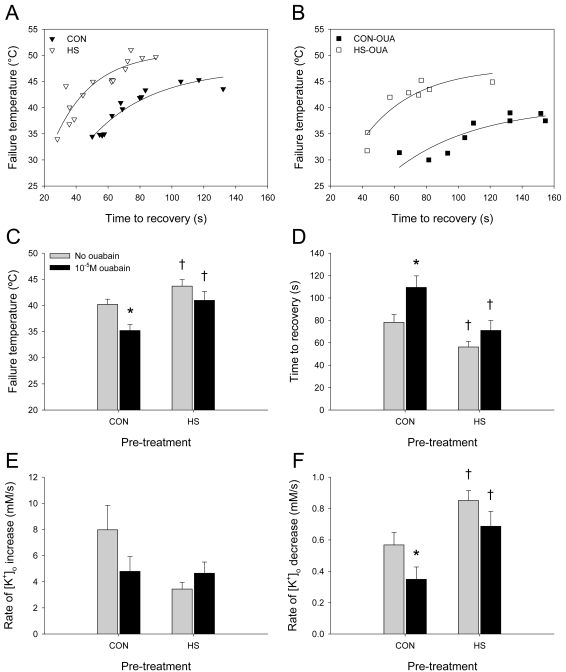
HS delays the [K+]o event and speeds recovery by increasing the rate of [K+]o clearance.A. Time to recovery was positively correlated with failure temperature in CON and HS locusts (NCON = 13; NHS = 15). Animals whose ventilatory motor pattern failed at a higher temperature had a longer time to recovery when temperature returned to normal levels. B. The correlations seen in CON and HS animals were shifted in animals treated with 10−5 M ouabain (NCON-OUA = 9; NHS-OUA = 8). The relationship between failure temperature and time to recovery in HS-OUA animals resembled CON animals. Data points for each group were fitted with exponential curves that rise to a plateau (A, B). C. Ventilatory motor pattern generation in HS locusts failed at a significantly higher temperature than in CON locusts with and without 10−5 M ouabain treatment. There was a significant effect of ouabain on the ability to withstand high temperature stress in CON locusts but not in HS locusts (NCON = 15; NCON-OUA = 9; NHS = 17; NHS-OUA = 8). D. Ventilatory motor pattern generation in HS locusts took significantly less time to recover following heat-induced failure than in CON locusts with and without ouabain treatment. CON-OUA locusts took significantly more time to recover than CON locusts, however there was no significant effect of ouabain treatment on time to recovery in HS locusts (NCON = 13; NCON-OUA = 10; NHS = 15; NHS-OUA = 8). E. Overall there were no main effects of HS pre-treatment or ouabain treatment on the rate of [K+]o increase (mM/s) associated with failure of the motor pattern (NCON = 15; NCON-OUA = 10; NHS = 18; NHS-OUA = 7). F. The rate of [K+]o decrease (mM/s) associated with recovery of the motor pattern was significantly greater in HS locusts than in CON locusts and this effect of pre-treatment was conserved in ouabain-treated locusts. Ouabain treatment significantly decreased the rate of [K+]o clearance in CON locusts but not in HS locusts (NCON = 15; NCON-OUA = 10; NHS = 18; NHS-OUA = 8). Asterisks indicate a significant effect of ouabain and daggers indicate a significant effect of pre-treatment according to post hoc Tukey tests (P<0.05) (C–F).